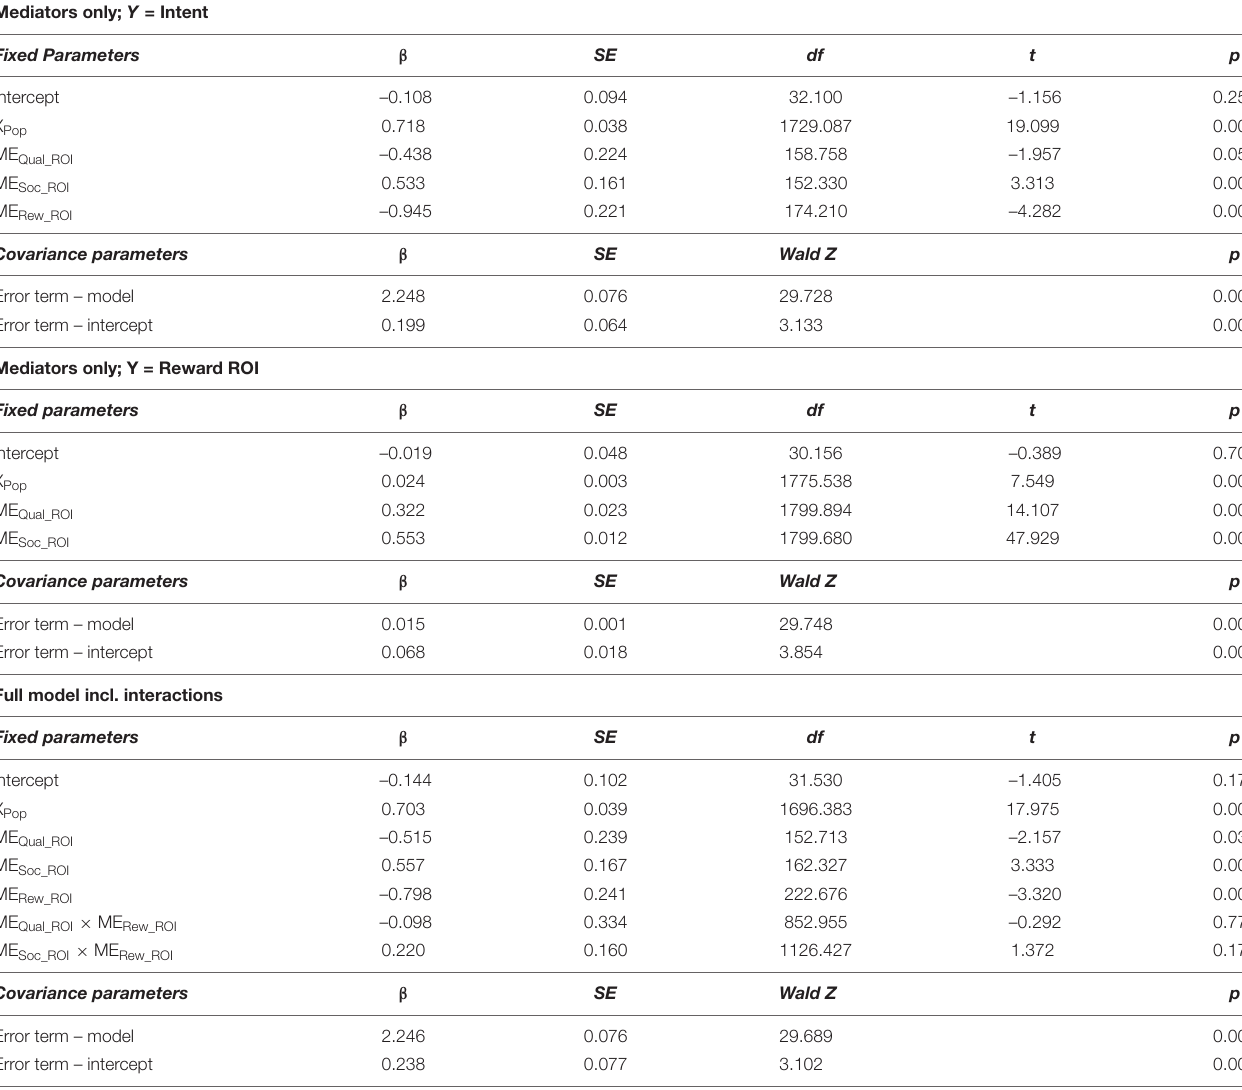
TABLE 3 | Parameters and test statistics for quality